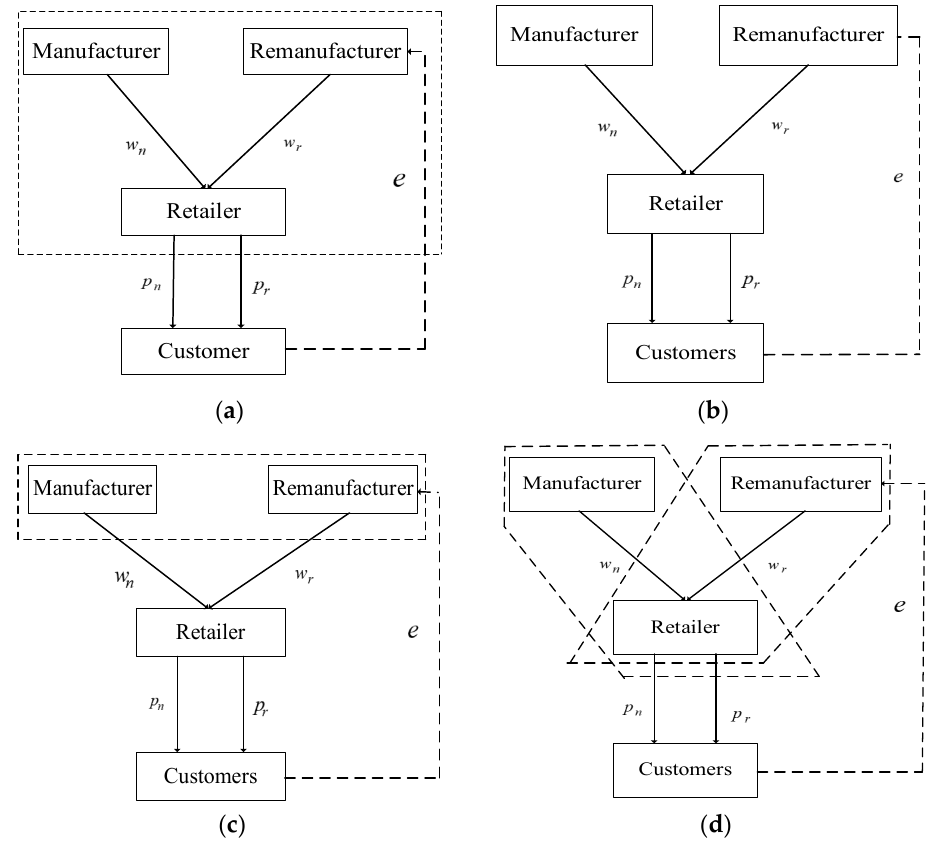
Figure 1. Four different green supply chain theoretical models. ( a ) model C; ( b ) model D; ( c ) model M-M; ( d ) model R-M-M.